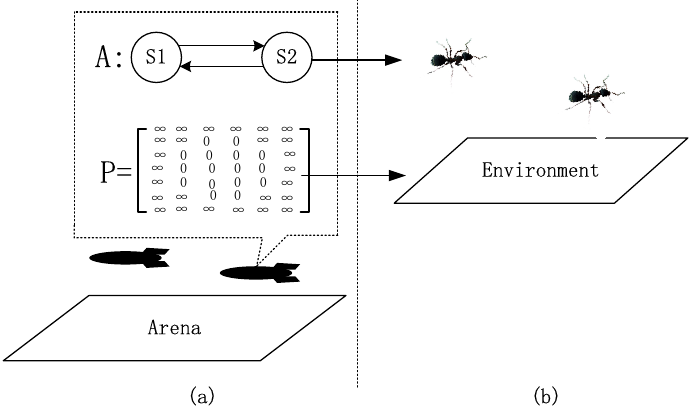
Figure 2. Structure of the controller. ( a ) is a robot swarm monitoring the environment and searching targets in the AOI, mimicking the foraging behavior of ants in ( b ). For each robot, the controller consists of two layers, with A being the behavior law and P being the pheromone map. The pheromone map is similar to the environment for ants to deploy and sense pheromones. Just like ants can make a decision based on pheromone information, the behavior controller A will generate a motion decision based on the pheromone map P . It can be seen that all ants in ( b ) share the same environment, but in ( a ) the pheromone maps for different robots differ due to the lack of real-time